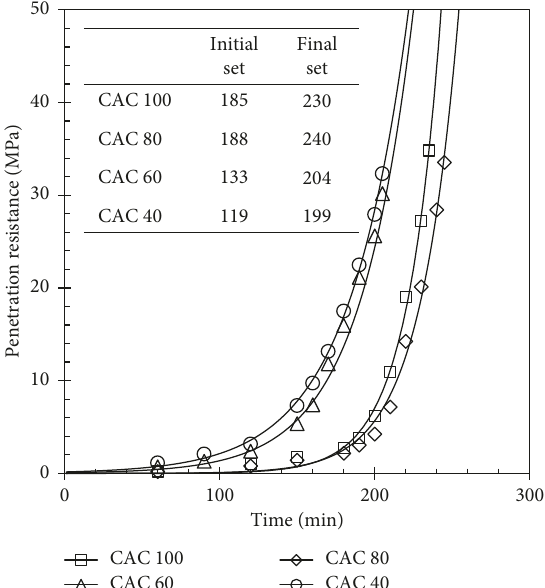
Figure 5: Penetration resistance with time for fresh mortar of CAC-GGBS mixtures. The curve is fitted by an exponential function (y � ae bx